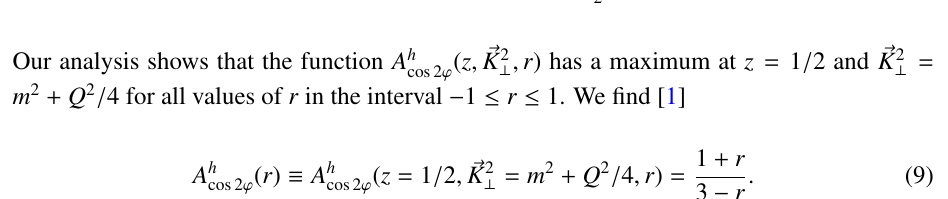
Figure 3. Left panel: azimuthal cos2 ϕ asymmetry A cos2 ϕ ( z ) ≡ A cos2 ϕ ( z , K 2 quark leptoproduction as a function of z at several values of λ = m 2 of the cos2 ϕ asymmetry with the contribution of linearly polarized gluons, A h